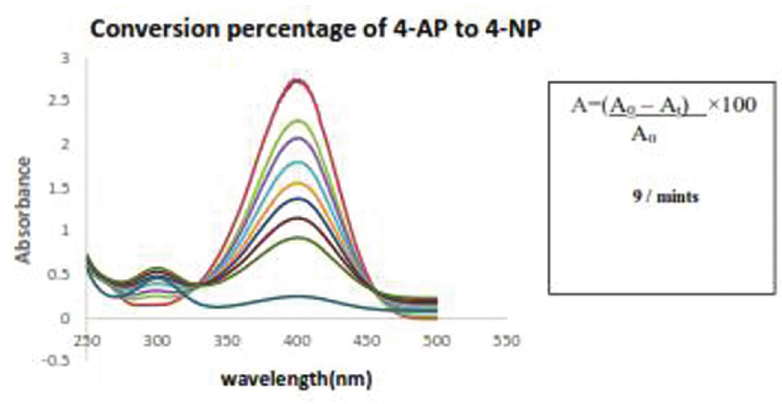
Figure 12: The successive conversion percentage of para-nitrophenol to para-aminophenol.